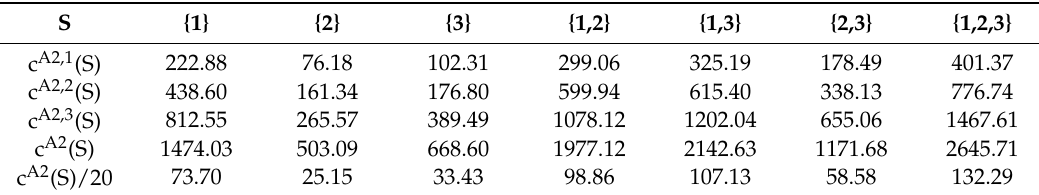
Table 8. Total investment cost game under alternative A2.